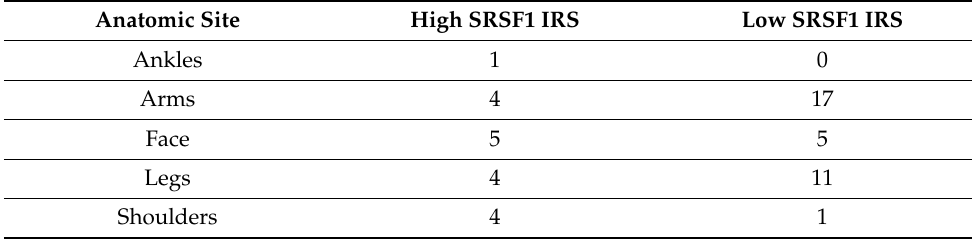
Table 4. Distribution of tumor anatomic sites according to SRSF1 immunoexpression.